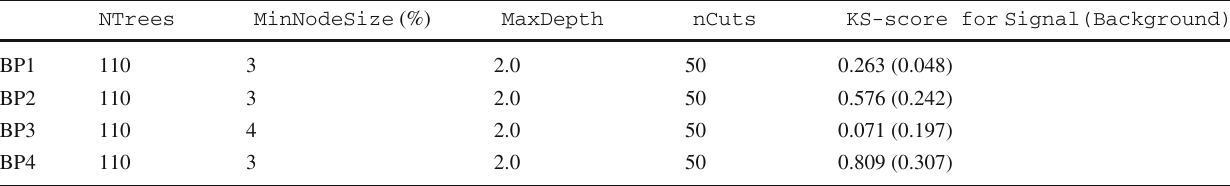
Table 11 Tuned BDT parameters for BP1, BP2, BP3 and BP4 for the 1 (cid:10) + 2 j + E / T